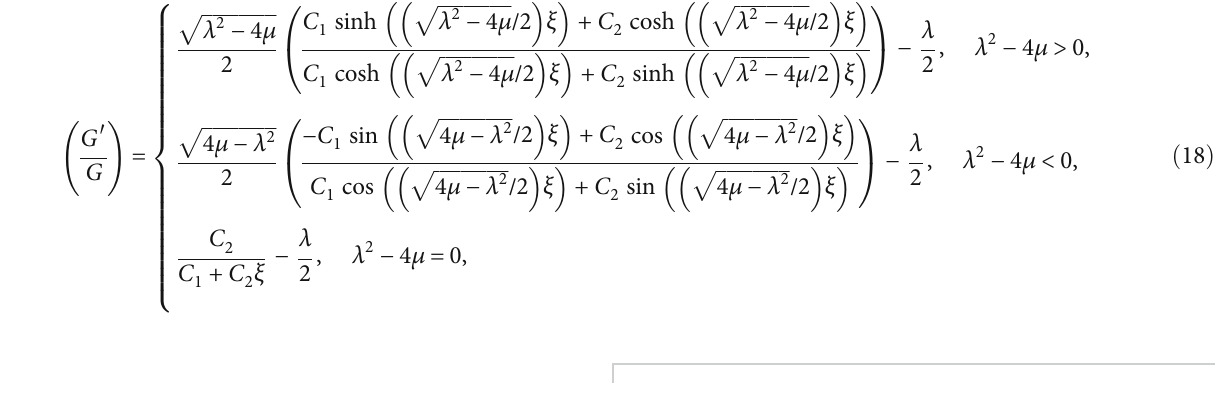
p λ 2 − 4 μ p λ 2 − 4 μ p 4 μ − λ 2 p 4 μ − λ 2